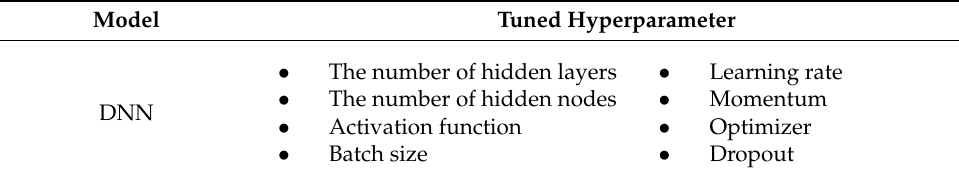
Table 4. List of tuned hyperparameters.